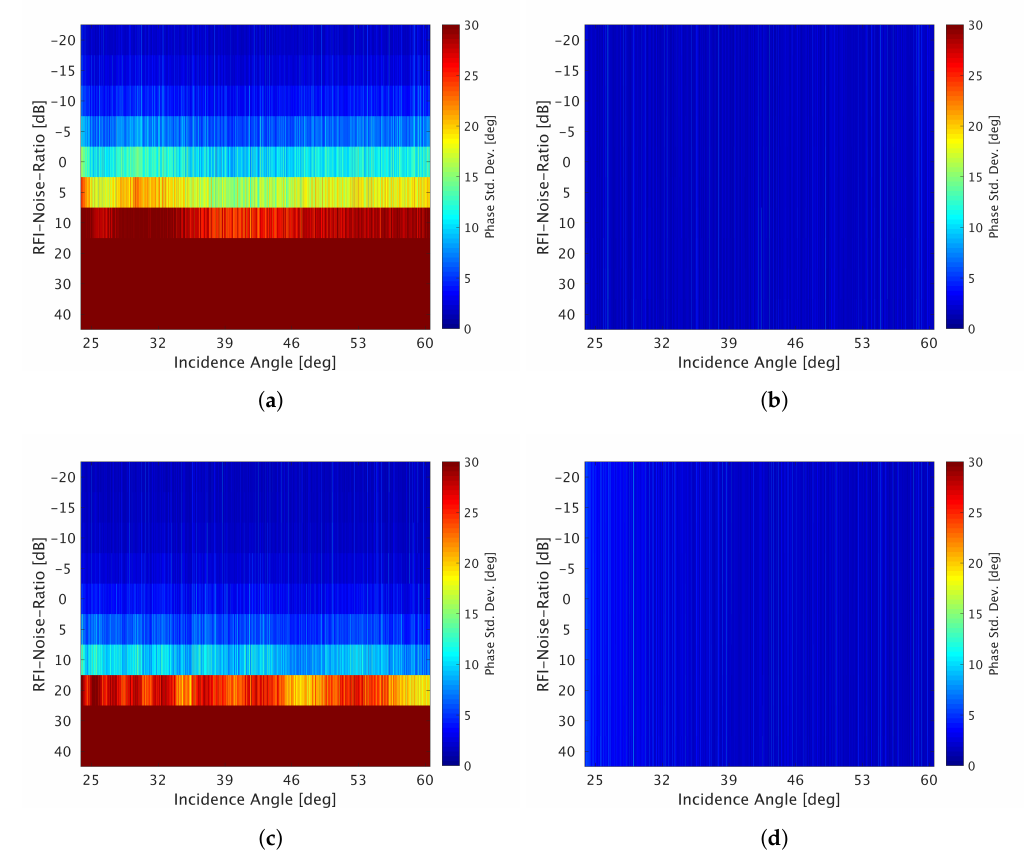
Figure 28. The phase standard deviation of the residual error image of scenario C for different RFI-Noise-Ratios versus the incidence angle of the instantaneous SAR signal. The SNR is 37.36 dB. ( a ) No RFI mitigation for N = 8, ( b ) After RD-Frequency MVDR beamforming for N = 8, ( c ) No RFI mitigation for N = 32, ( d ) After RD-Frequency MVDR beamforming for N =